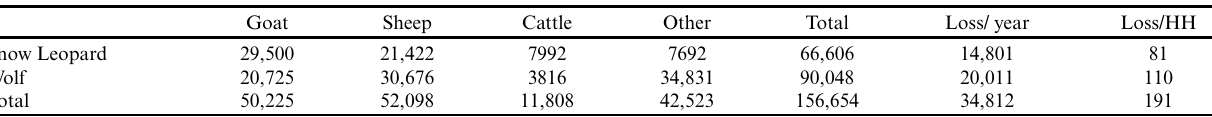
Table 4 . Predator specific monetary losses (US$) incurred by respondents in the study sites.